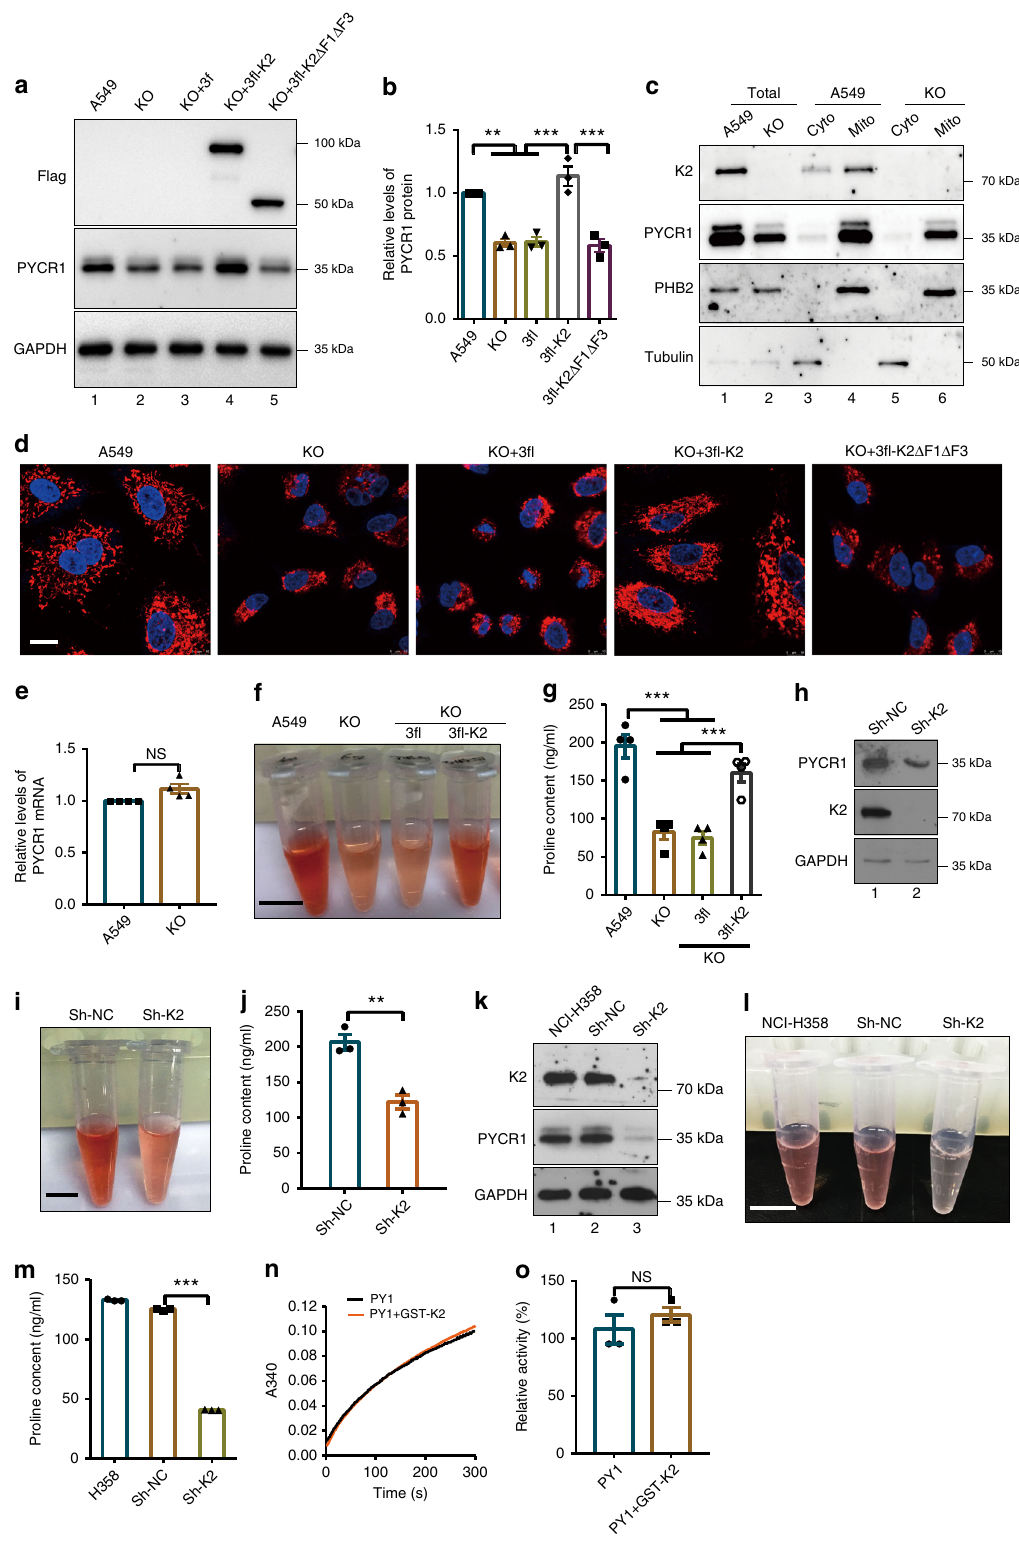
Kindlin-2 regulates cell survival and proliferation . Concomitant to the reduction of PYCR1 and proline levels, knockdown of kindlin-2 (Fig. 5a, lane 2) signi fi cantly increased ROS production (Fig. 5b, c) and apoptosis (Fig. 5d, e). Re-expression of FLAG- kindlin-2 in kindlin-2 knockdown cells (Fig. 5a, lane 4)